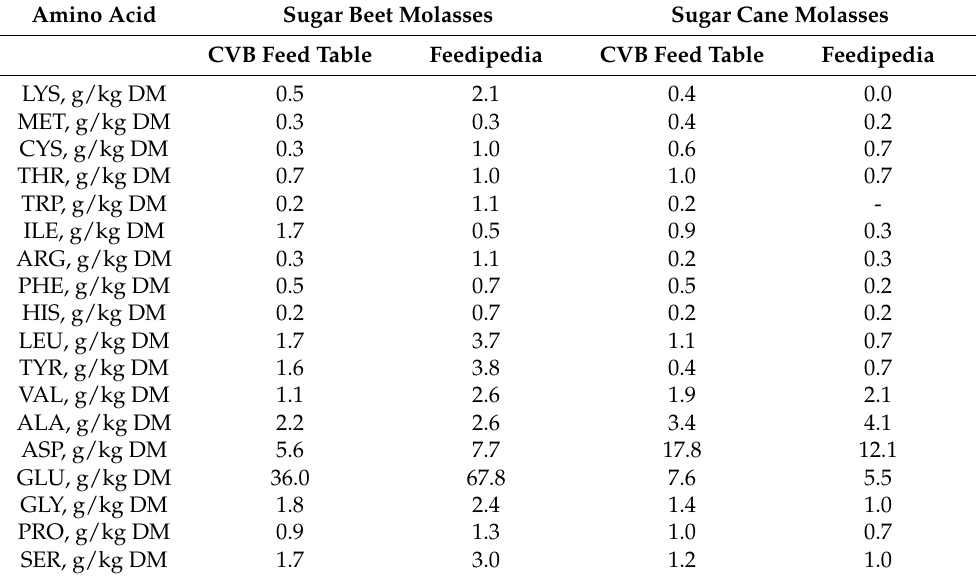
Table 4. Amino acid contents per kg of sugar beet and sugar cane molasses (modified from the CVB Feed Table 2019. Chemical composition and nutritional values of feedstuffs. www.cvbdiervoeding.nl; and from